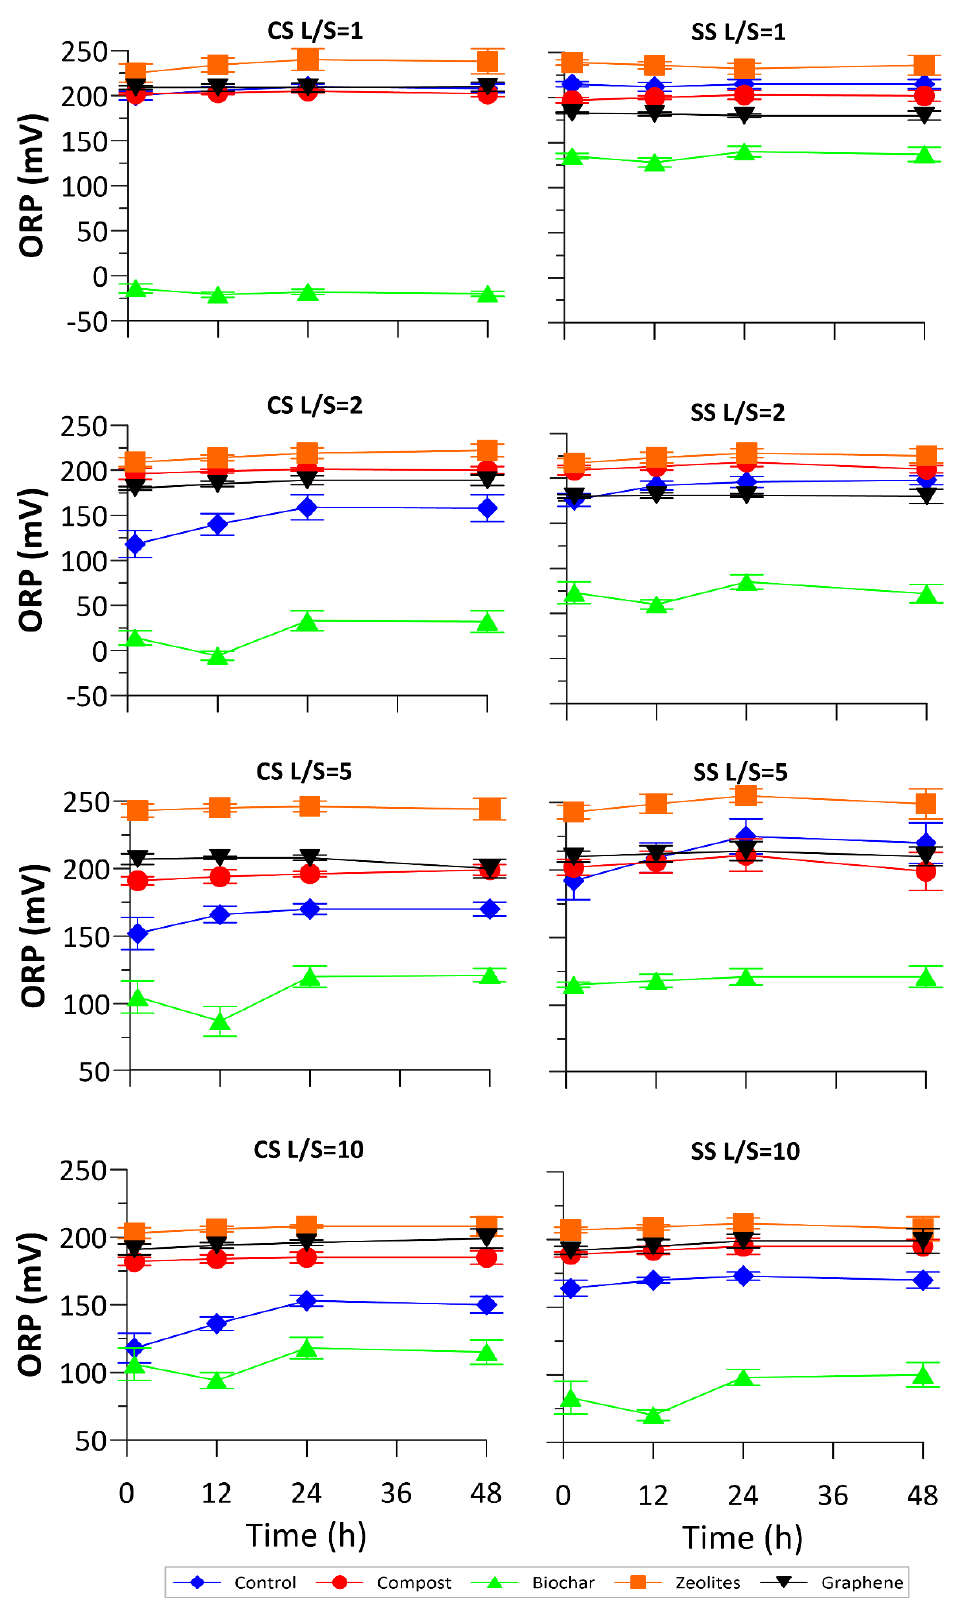
Figure 5. ORP values variations in SSE batches experiments with CS ( left panels ) and SS ( right panels ) for different L/S ratios. Error bars denoted standard deviation calculated on three replicas.